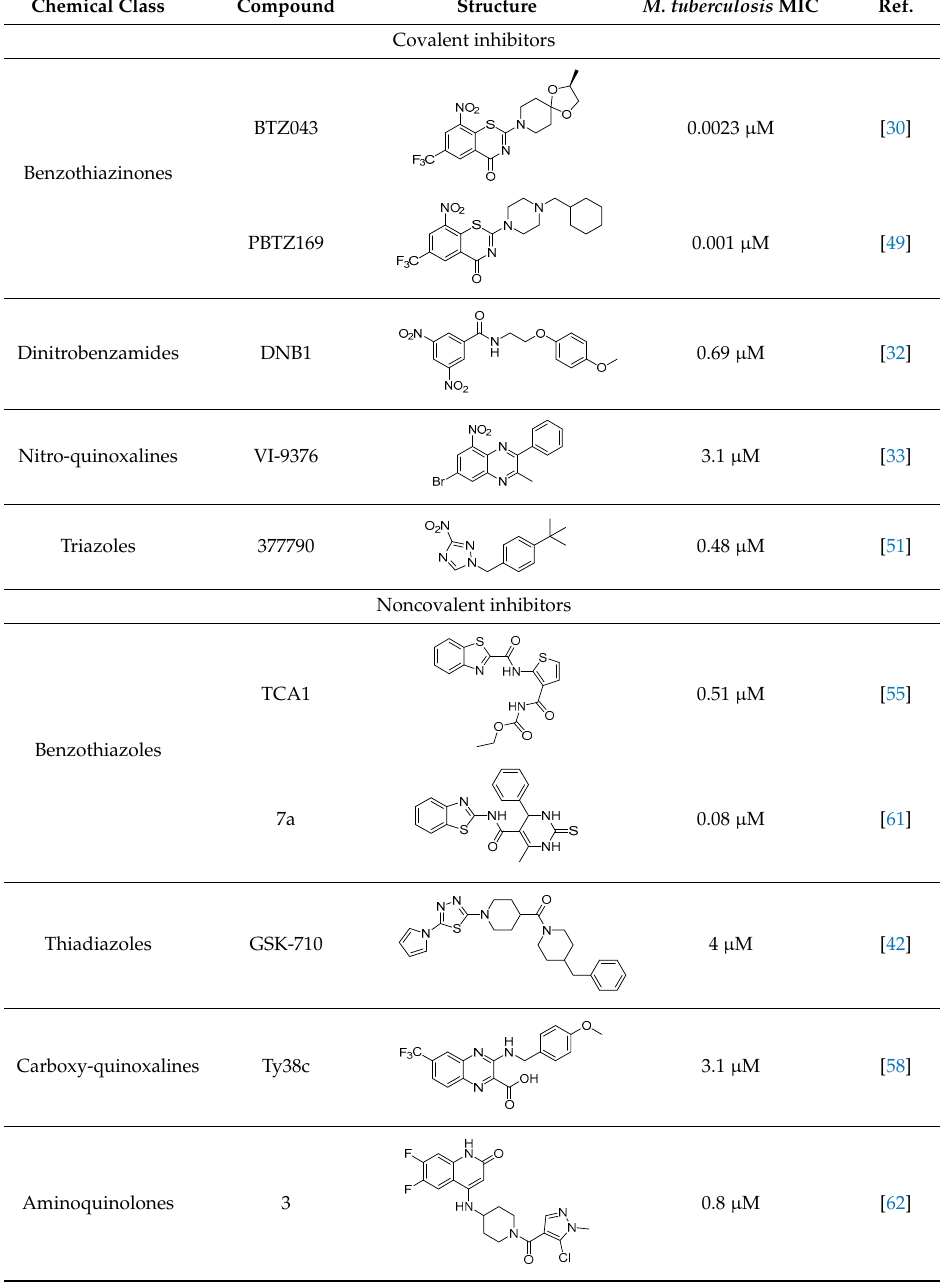
Table 1. Main covalent and not covalent DprE1 inhibitors showing antitubercular activity. Chemical Class